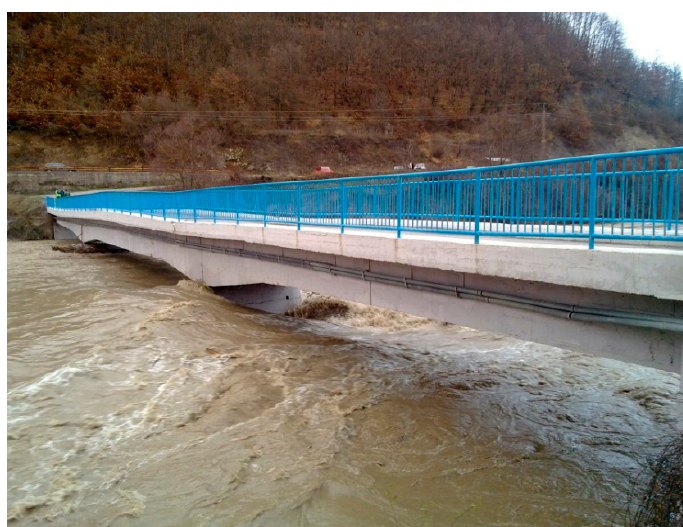
Figure 2. Lim River water level in the area of the Marsenic bridge.